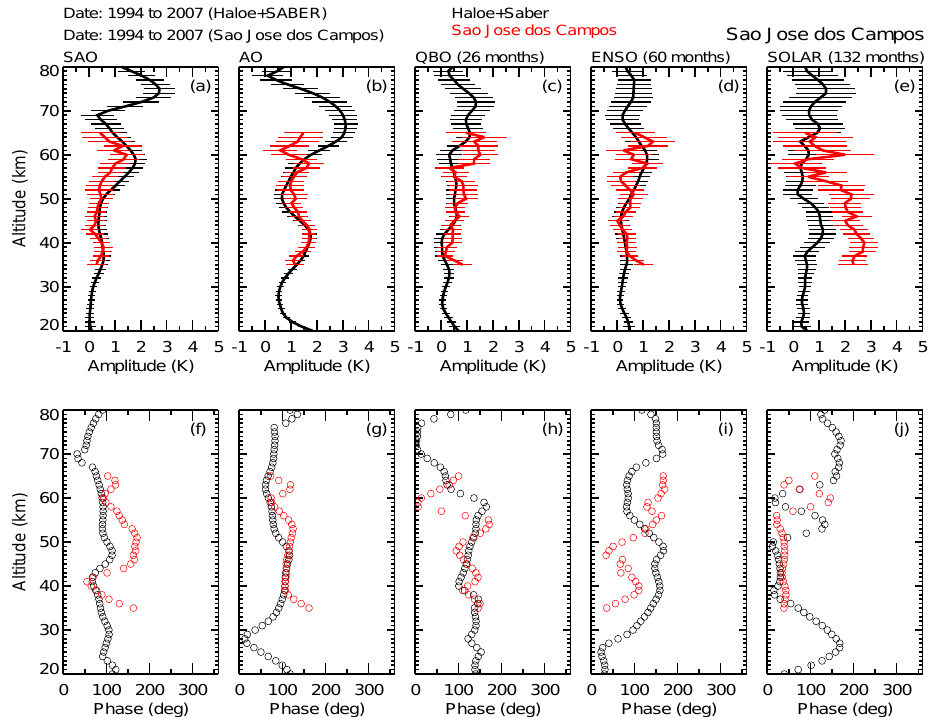
Fig. 6. Amplitudes observed in (a) SAO, (b) AO, (c) QBO (26 months), (d) ENSO (60 months), and (e) solar (132 months) over São José dos Campos location obtained using combined measurements of HALOE and SABER (1994–2007). Amplitudes observed using Lidar located at São José dos Campos during the same period is also superimposed in respective panels. Corresponding phases are shown in panels (f) – (j) , respectively. The horizontal bars indicate 2-sigma error